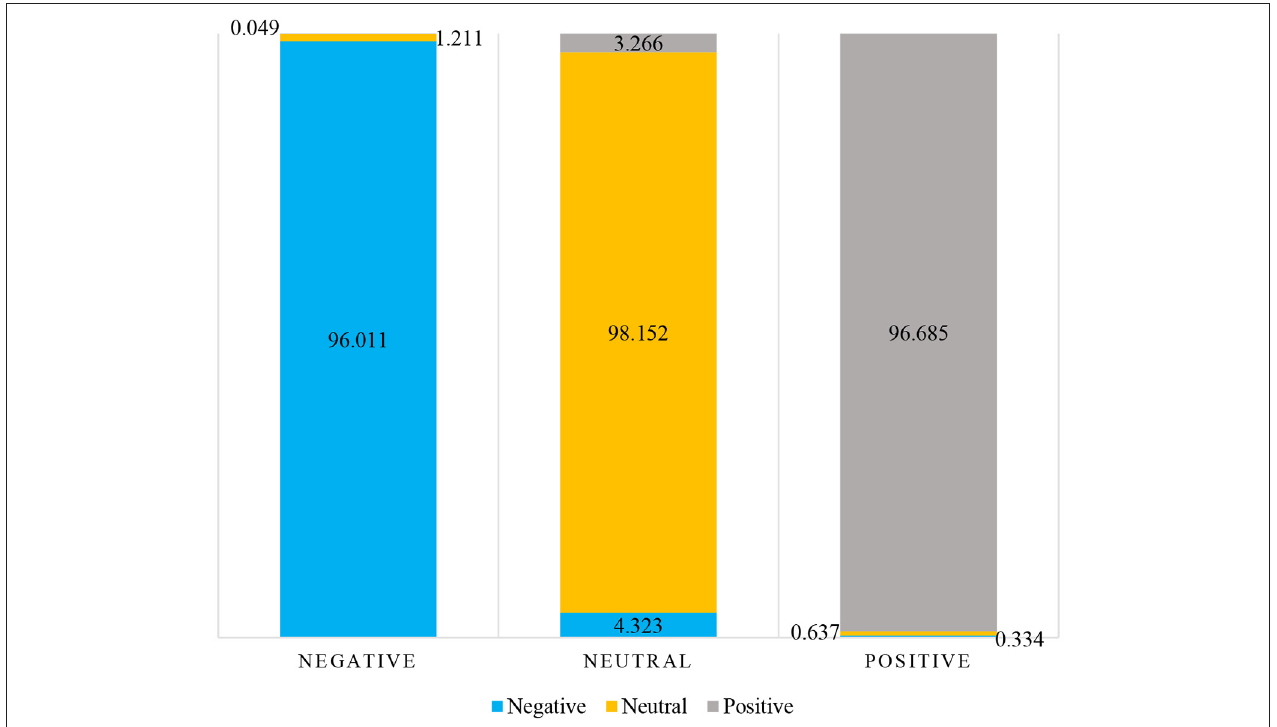
FIGURE 8 | Percentage stacked column chart of dual-channel emotion recognition confusion